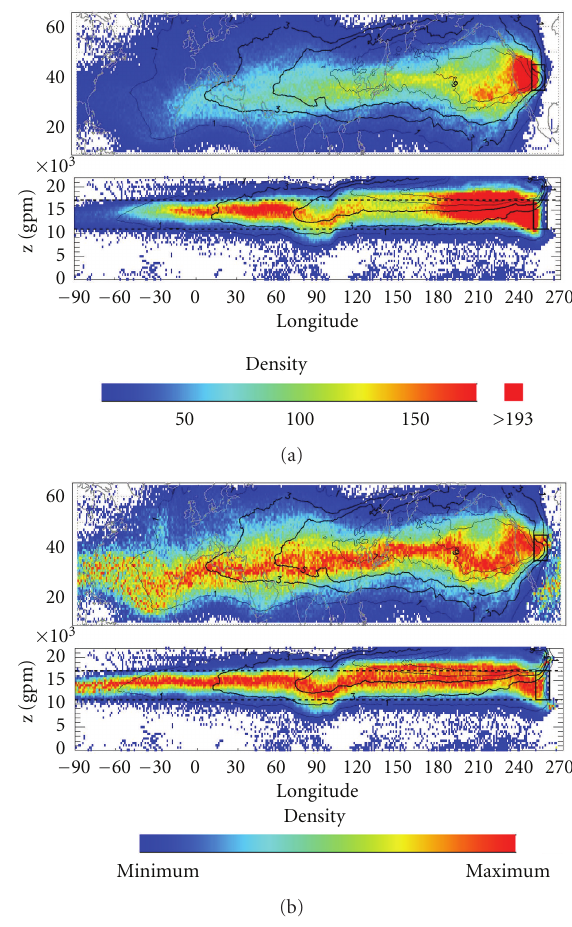
Figure 3: Particle density (colour scale) and smoothed contours of averaged PV (isolines of 1, 3, 5, 7, and 9PVU). In the upper panels (latitude-longitude representation), the black square on the right-hand side represents the region near Boulder where particles arrive at t 0 . In the lower panels (height-longitude representation), the rectangle represents a boundary of 5 degrees of longitude surrounding Boulder. The dotted black lines show the average heights of the first and second tropopauses. (a) Sum for the ten days before t 0 . (b) Similar to (a) but representing the maximum density for each degree of